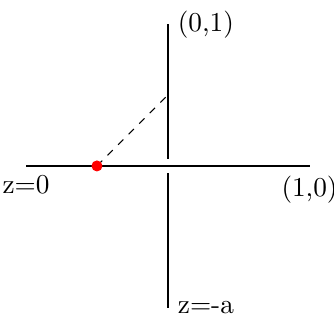
Figure 13 . Toric diagram for the deformed conifold with probe D-branes on L intersecting the S 3 . For the simplicitiy, we have not specified the frame of the D-brane and the probe brane is depicted as a red